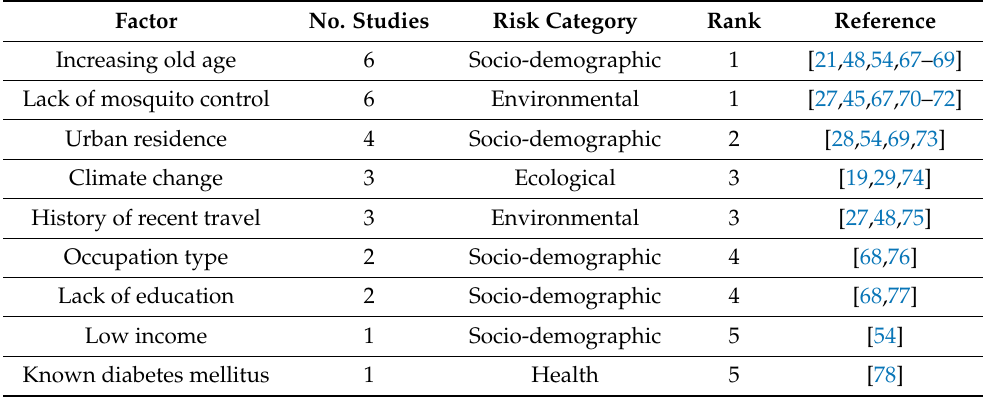
Table 4. Potential risk factors of dengue virus infection in Africa ( n = 21 studies). Factor No.